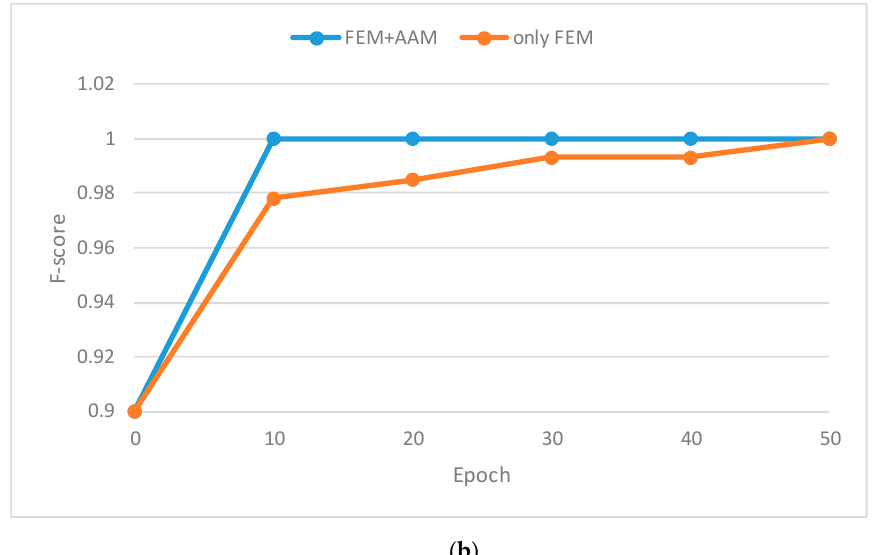
Figure 4. ( a ) Test samples of segmentation network (FEM: feature extraction module; AAM: anomaly attention module). The red squares represent the areas erroneously detected due to background interference; ( b ) Relevant test f-score variations in training process of classification network (the initial value is set as 0.9).